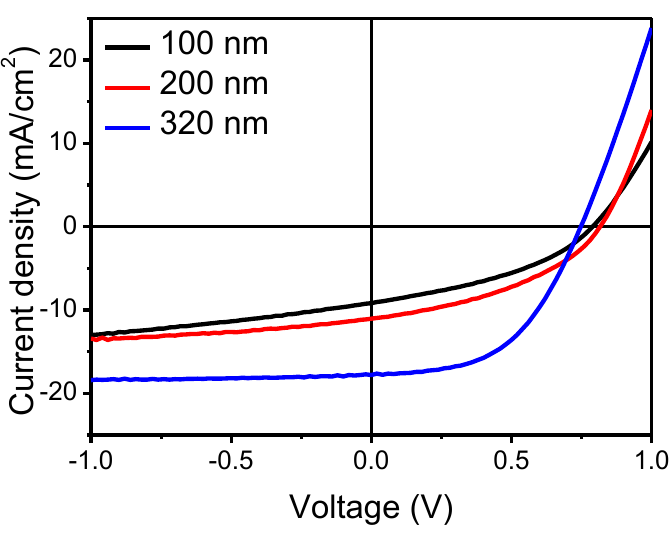
Figure 2. Measured density/voltage ( J - V ) curves of SM BHJ OSCs.